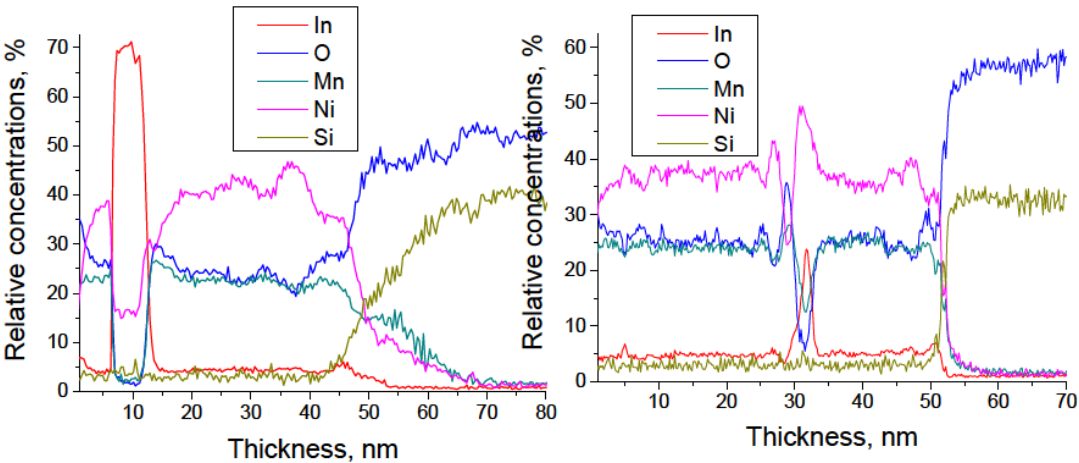
Figure 3: The distribution of elements by depth for an as-grown sample of Ni-Mn-In deposited in vacuum ~7 · 10 −4 Pa, obtained by AES ion profiling